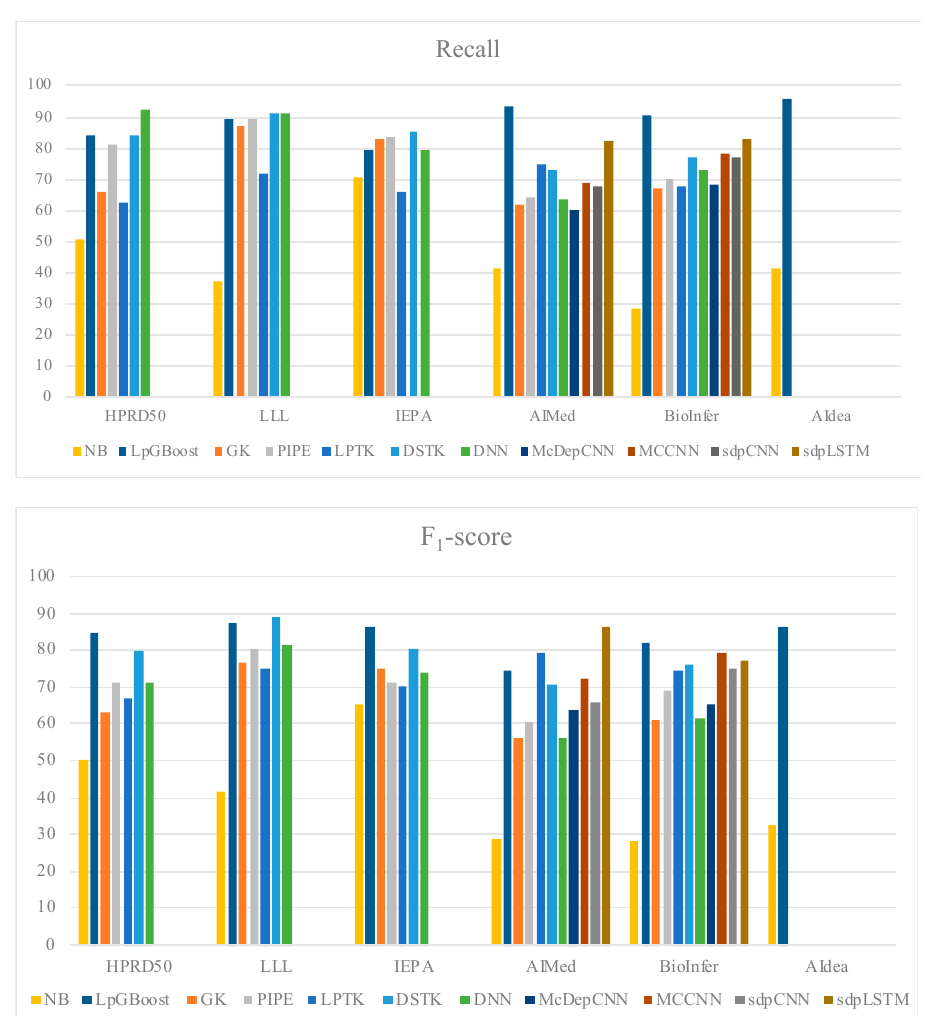
Figure 3. Comparative analysis on precision, recall, and F 1 ‐ score. Table 3. XGBoost-based comparative feature analysis on HPRD50